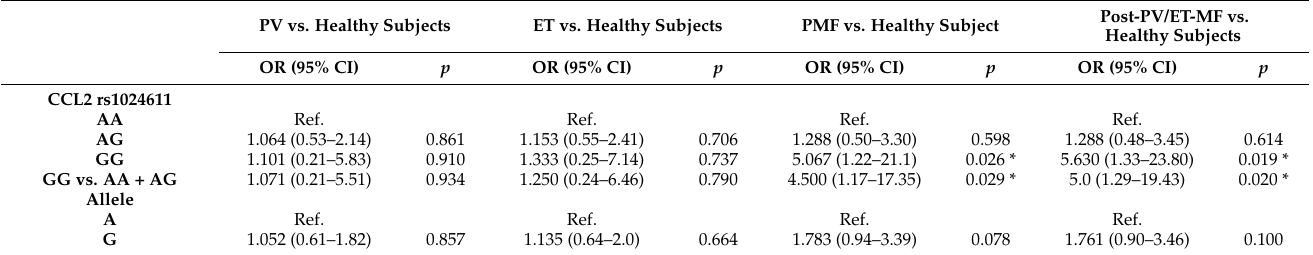
Table 3. The CCL2 rs1024611 SNP risk associated with the developing Philadelphia-negative MPNs.